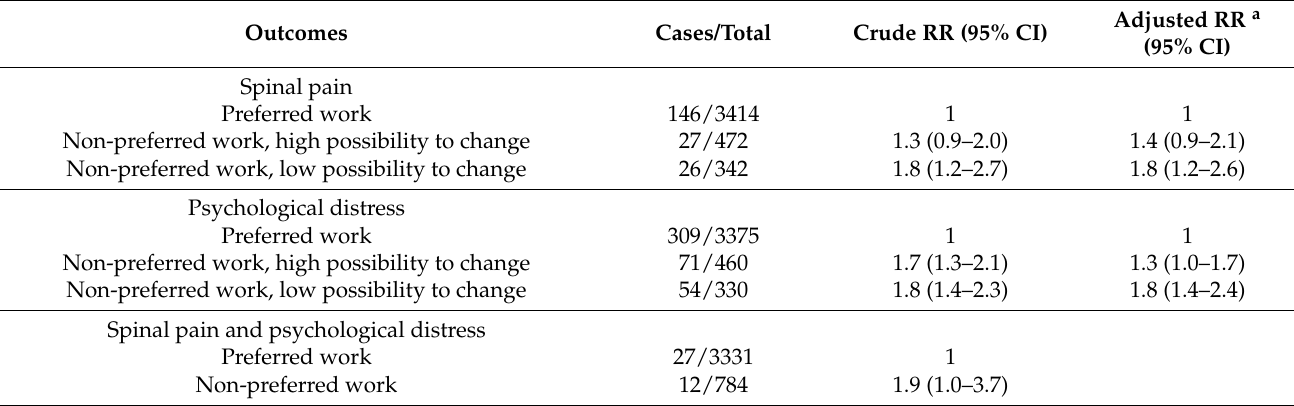
Table 3. Associations between non-preferred work and the incidence of spinal pain, psychological distress and spinal pain with concurrent psychological distress (n = 4285).